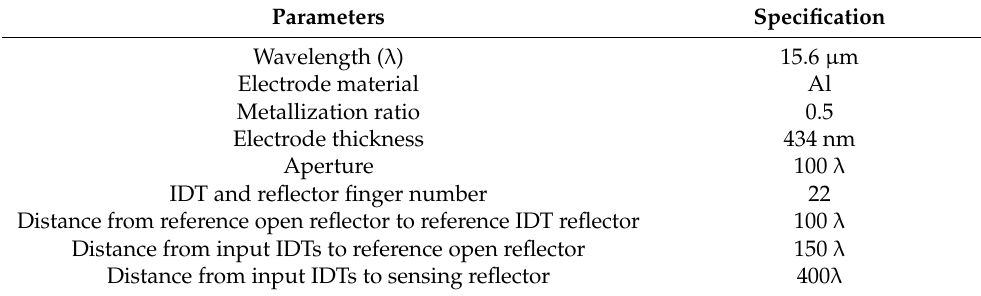
Figure 10. Experimental setup.